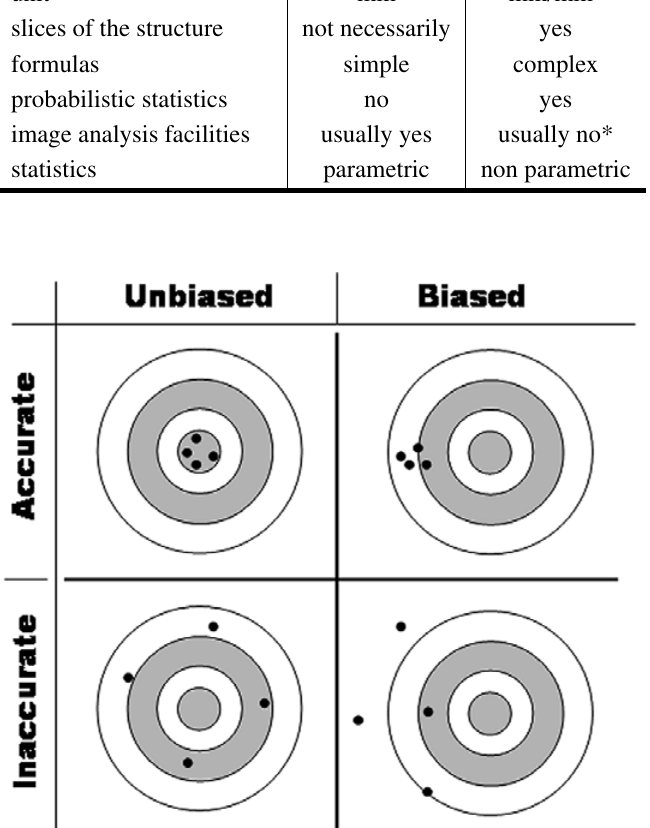
Fig. 2 – Schematic illustration of the difference between accuracy and bias. The top row of targets shows accuracy that is the hits are closely clustered together. The bottom row shows inaccuracy and there is a marked scatter of hits. In the left hand column the average of the cluster of hits tends towards the bull’s-eye, which means that they are unbiased. The right hand column shows the converse case, these hits are biased (based on Howard and Reed